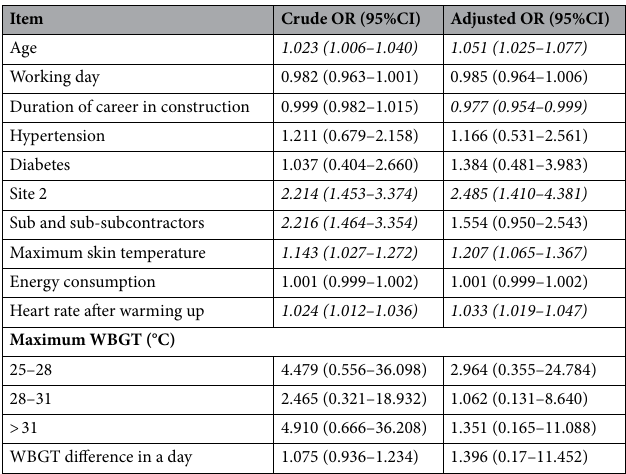
Table 4. Logistic regression of heat-related illness risk. Italic font describes significant difference ( p < 0.05). OR odds ratio, CI confidence